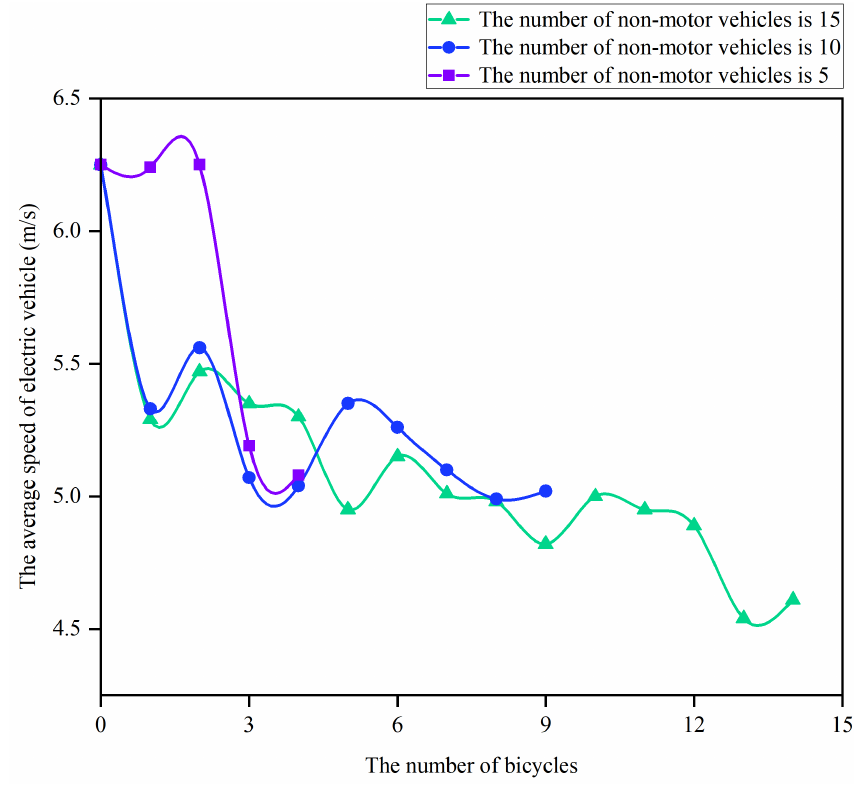
Figure 12. The effect of the number of bicycles on the average speed of electric